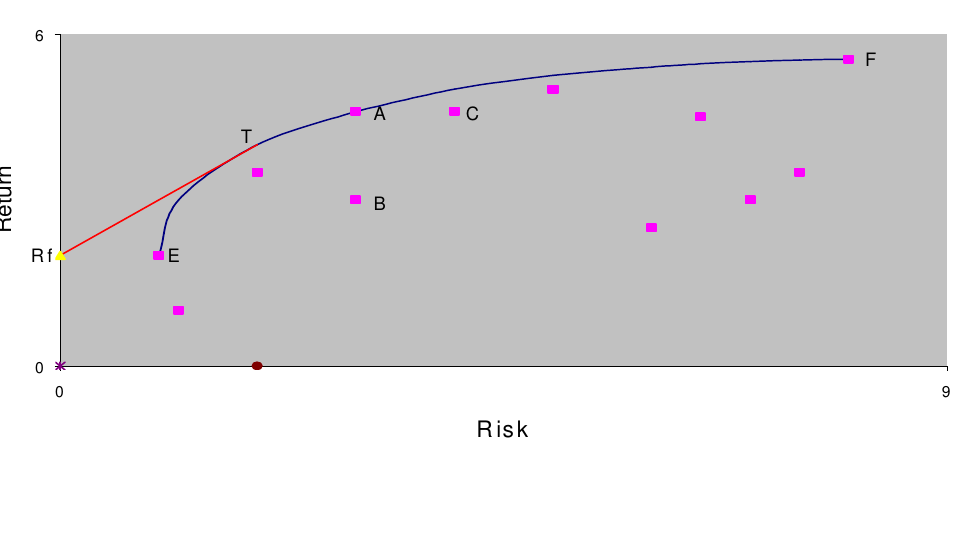
Figure 1: The E fficient